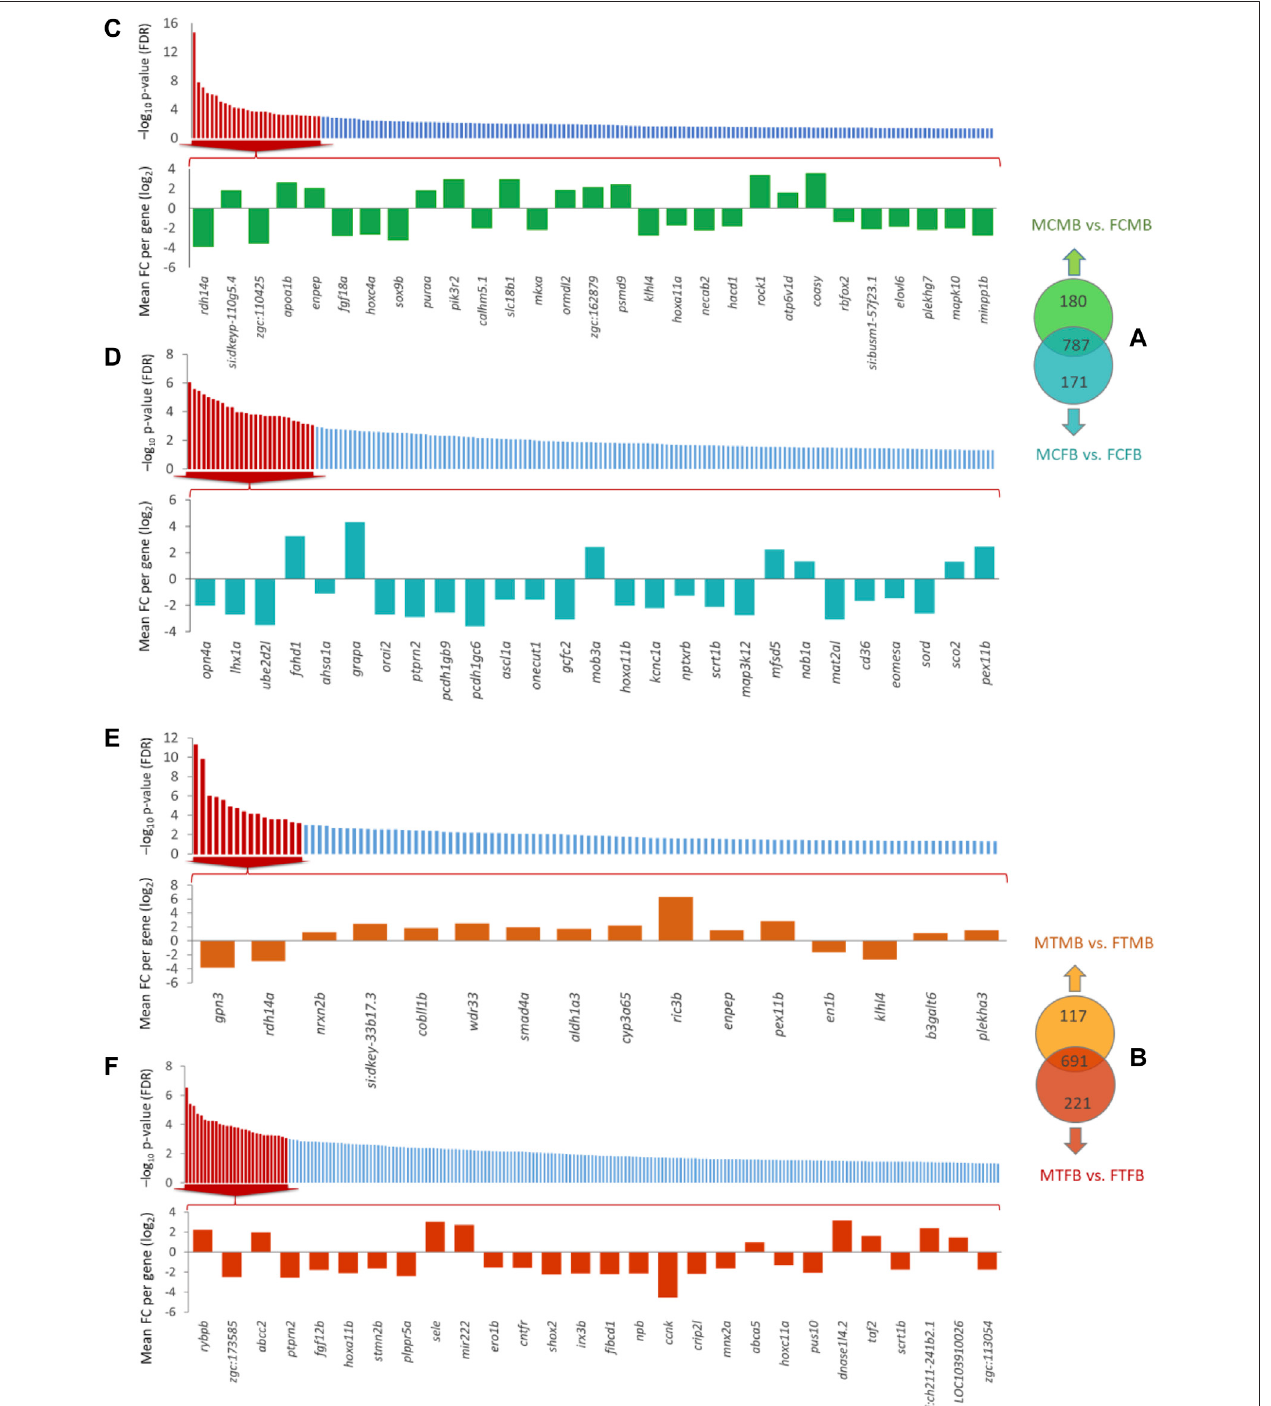
FIGURE 9 | Genes associated with the signi fi cantly differentially methylated promoters comparing testes versus ovaries within sex-biased families. Venn diagrams illustrate the differences in methylated gene promoters comparing male-biased and female-biased families in the control (A) and treatment (B) groups. Bar charts illustratethelevelofthesigni fi cance(FDR < 0.05)foralluniquegenesineach sex-biased family,and thedifferentiallymethylatedoftopsigni fi cantuniquegenepromoters with FDR < 0.001 in male-biased and female-biased families, as classi fi ed in Venn diagram, in different experimental groups: (C) Male control male-biased versus female control male-biased (MCMB vs. FCMB); (D) Male control female-biased versus female control female-biased (MCFB vs. FCFB); (E) Male treatment male-biased versus female treatment male-biased (MTMB vs. FTMB); (F) Male treatment female-biased versus female treatment female-biased (MTFB vs. FTFB).